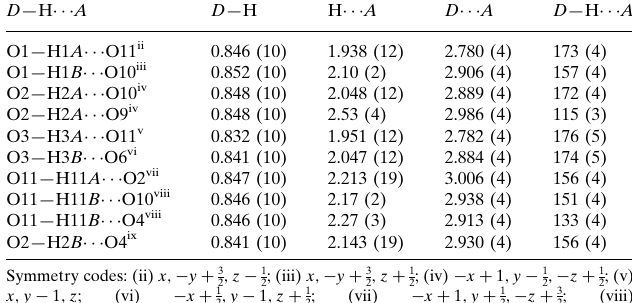
Hydrogen-bond geometry (A˚ , (cid:4) ). D —H (cid:1)(cid:1)(cid:1)